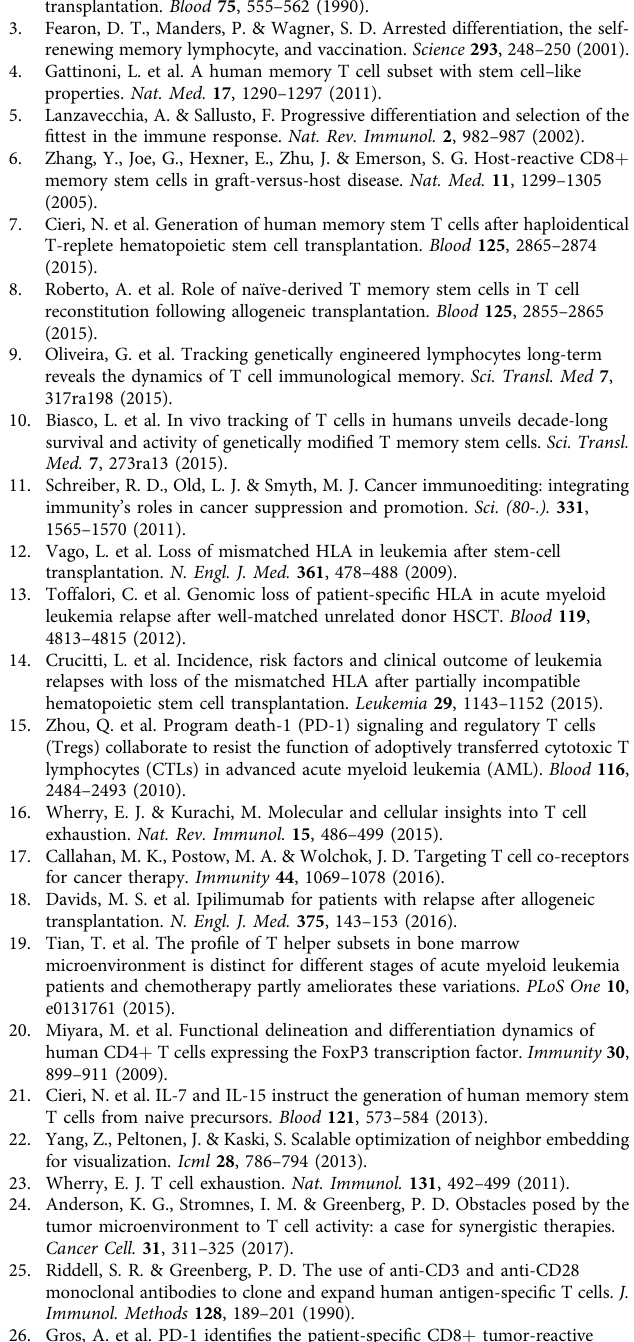
Fig. 6 A phenotype of exhaustion characterizes tumor-speci fi c T cells early after transplant. a Proportion of PD-1 + CD8 + BM-T cells expressing T-bet and EOMES transcription factors in different T-cell subsets of healthy donors (HD, N = 8), patients who will maintain long-term complete remission (CR, N = 37) or will experience disease relapse (REL, N = 20). b BH-SNE analysis of CR and REL CD8 + BM-T cells at this early time point. The BH-SNE1/BH-SNE2 biaxial plot for CR and REL and the composition of HLA-DR − clusters are reported (left), together with the MFIs of inhibitory receptors (center) and the percentages (right) of CD8 + BM-T cells expressing inhibitory receptors in the CR- and REL-speci fi c HLA-DR − clusters. c Representative plot of inhibitory receptors expression by CR or REL tumor-speci fi c CD8 + T cells and their quanti fi cation by histograms, compared with viral-speci fi c CD8 + T cells. d Percentages of expression of multiple inhibitory receptors by viral and tumor-speci fi c T cells. Individual patient data points, means, and SEM are shown. Statistically signi fi cant differences between CR and REL groups are highlighted in red and the differences between patients ’ groups and HD in black. * p